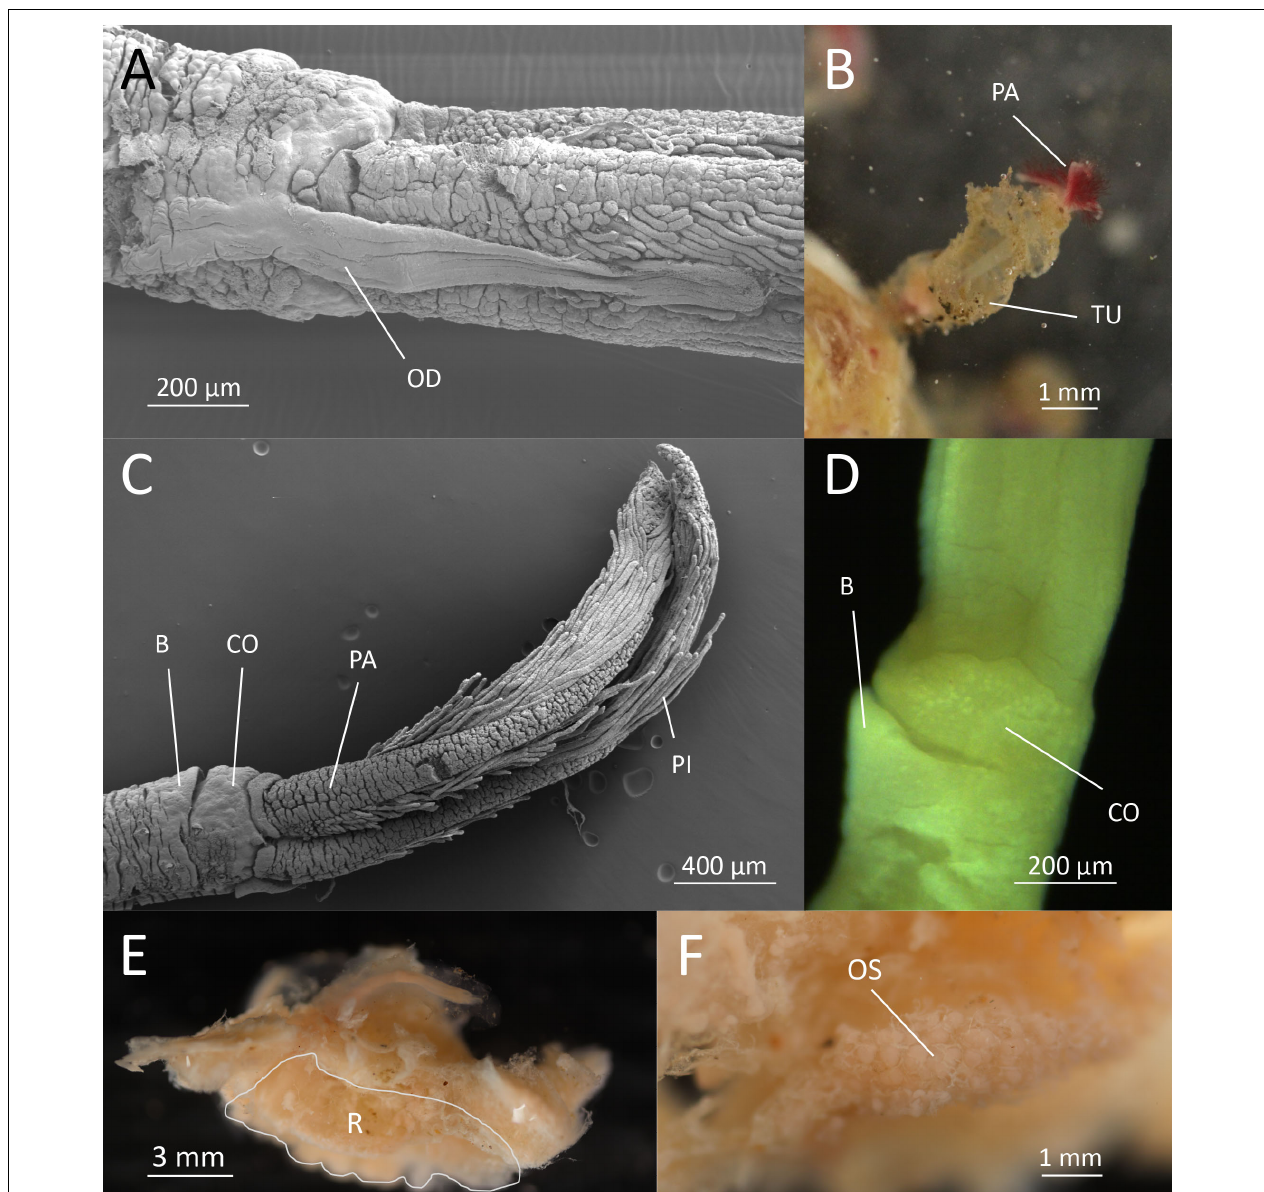
FIGURE 1 | Osedax fenrisi sp. nov. (A) SEM. Dorsal view. Oviduct (OD) extending between the dorsal most palps. (B) Live image from tank. Red palps (PA) extending out from mucous tube (TU). (C) SEM. Lateral view. Ventral collar (CO) visible with a small bump (B). (D) Light microscopy. Ventral view. Bump (B) visible on the lower rim of collar (CO). (E) Formalin fixed female dissected out of bone with attached bone material. The root tissue is indicated (R). (F) Ovisac (OS) in formalin fixed root